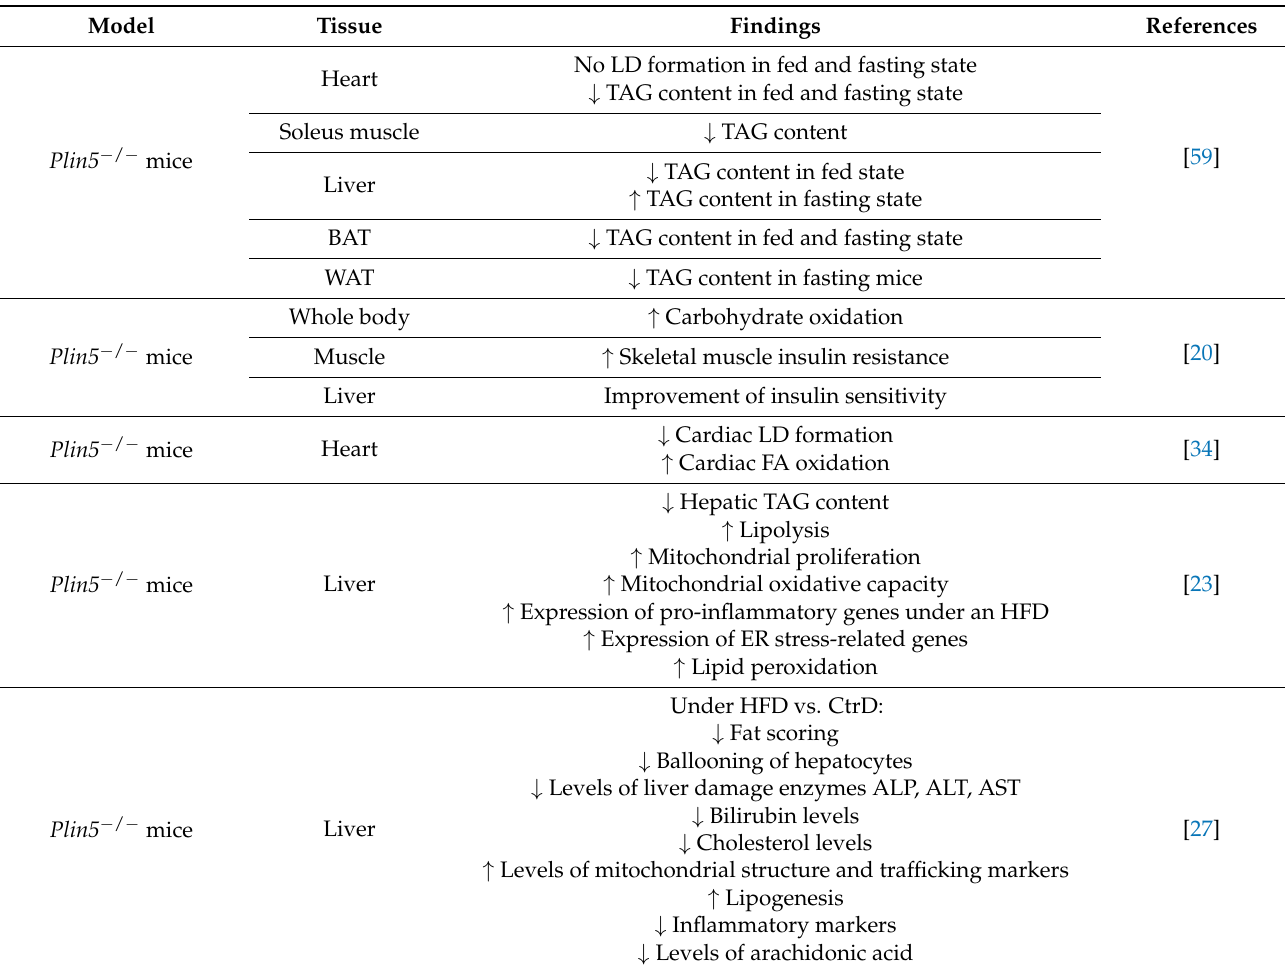
Table 1. Phenotypes of Plin5 transgenic mouse